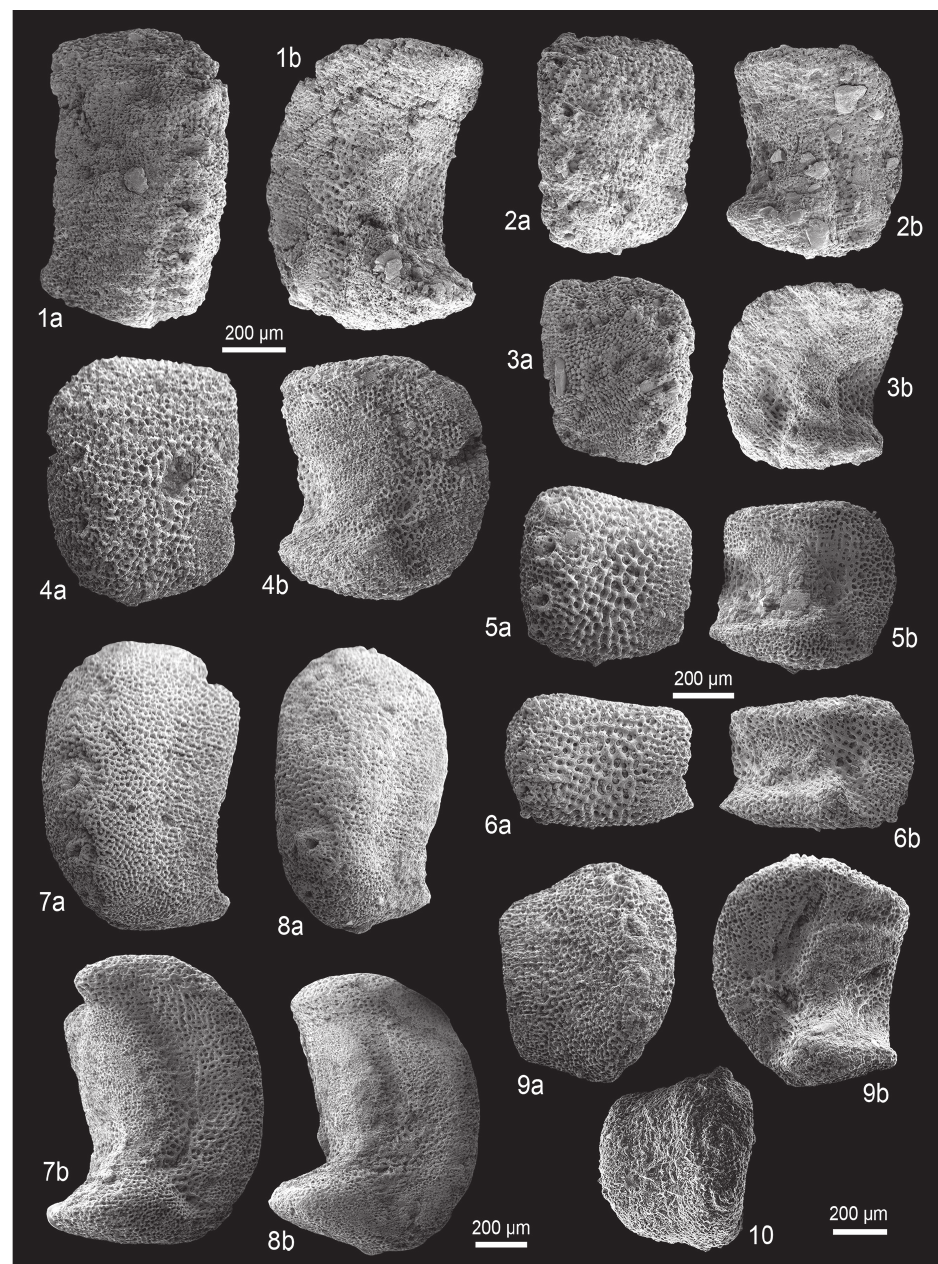
Fig. 33. Fossil lateral arm plates (LAPs) of ophiacanthid brittle stars in external (a) and internal (b) views. 1-3. Inexpectacantha ritae sp. nov. from the Hettangian (Early Jurassic) of Bourglinster, Luxembourg. 1. MnhnL HE419 (holotype), proximal LAP. 2. MnhnL HE420 (paratype), median LAP. 3. MnhnL HE421 (paratype), distal LAP. 4-6. Inexpectacantha weisi sp. nov. from the Hettangian